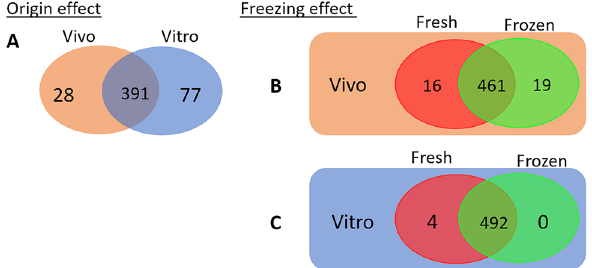
Figure 6. ( A ) Representation of differential lipids between fresh in vivo and in vitro embryos through a Venn diagram. In vivo produced embryos are represented by an orange ellipse and in vitro produced embryos are represented by a blue ellipse. ( B ) Representation of lipid differentials between fresh (red ellipse) and frozen (green ellipse) in vivo produced embryos through a Venn diagram. ( C ) Representation of lipid differentials between fresh (red ellipse) and frozen (green ellipse) in vitro produced embryos through a Venn